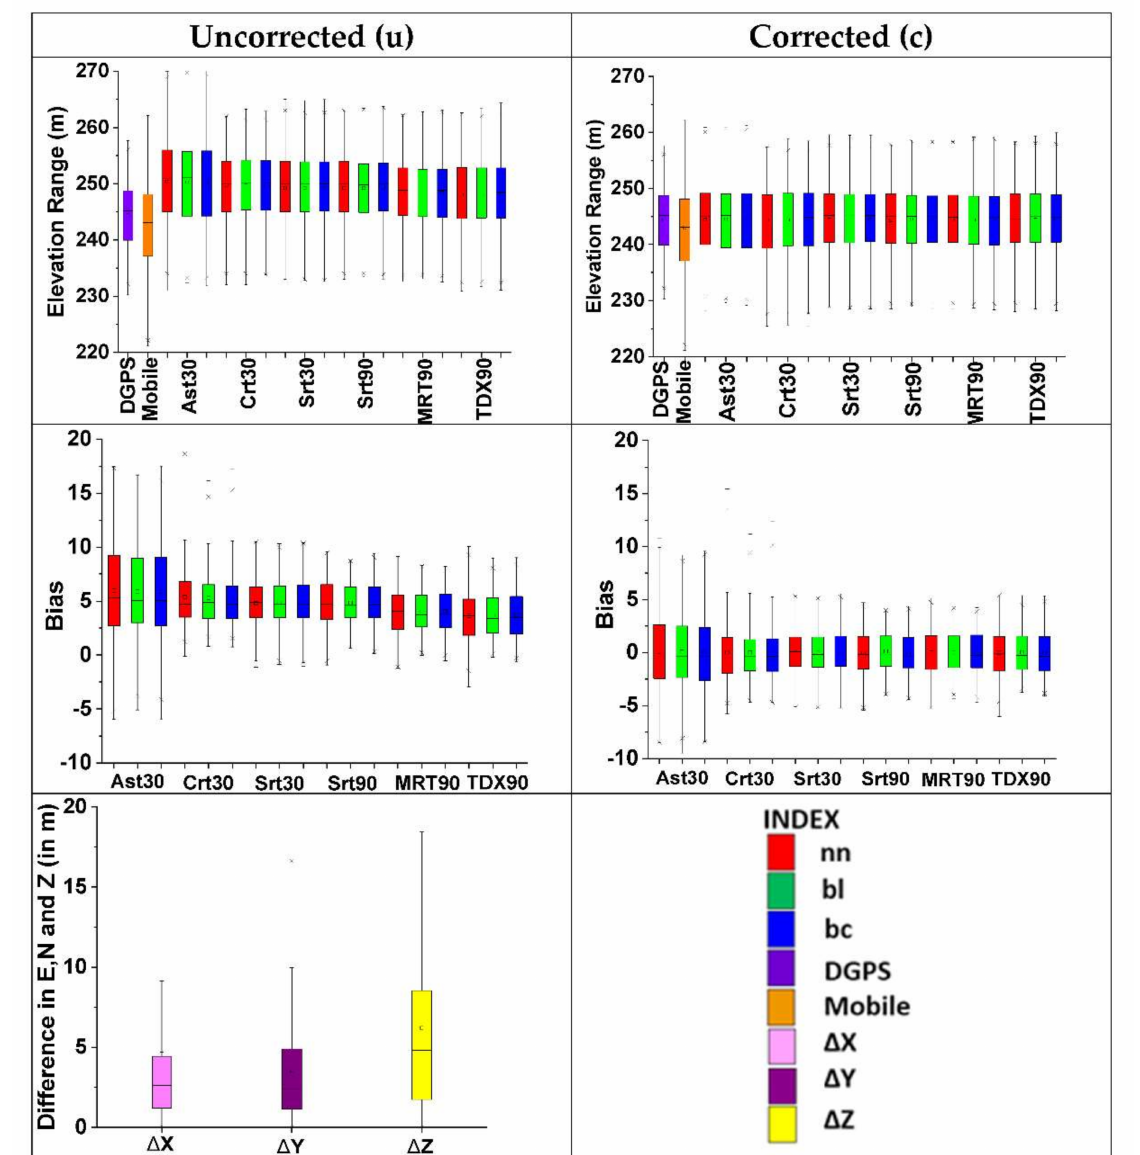
Figure 3. Boxplots exhibit the impact of correction on the elevation range ( upper panel ) and bias ( middle panel ) and depict the differences in values of the positional attributes ( ∆ X, ∆ Y, ∆ Z, shown as lower panel ) observed at GCPs by DGPS and MobileGPS. The nn, bl, and bc refer to the interpola- tion